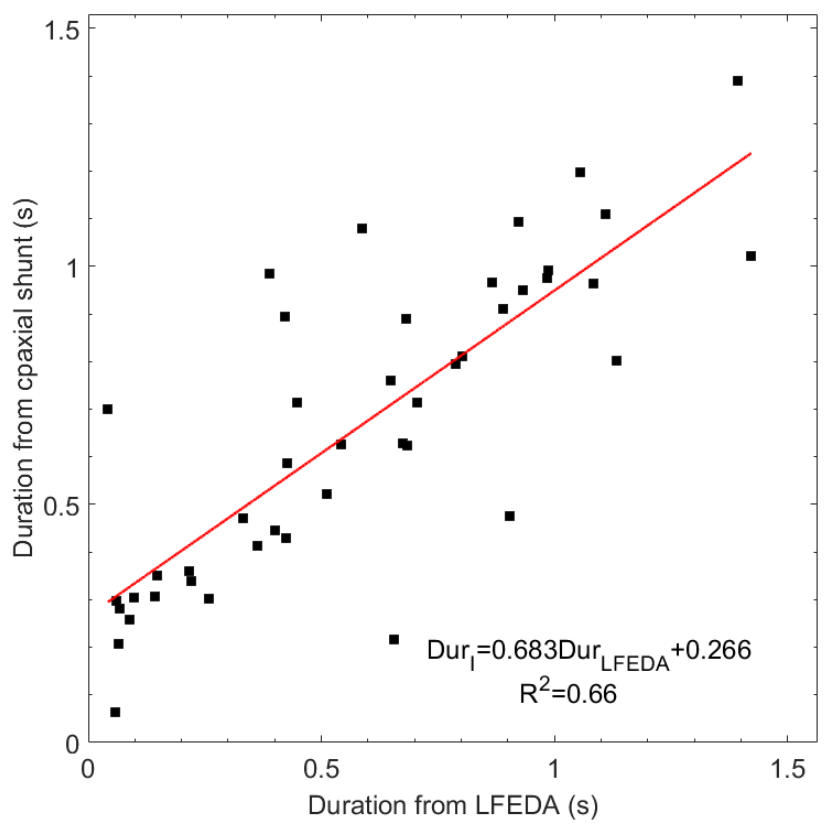
Figure 4. Scatter distribution (solid squares) and linear fitting (red line) of TLF durations suggested by the LFEDA data (DurLFEDA) and current data (DurI).